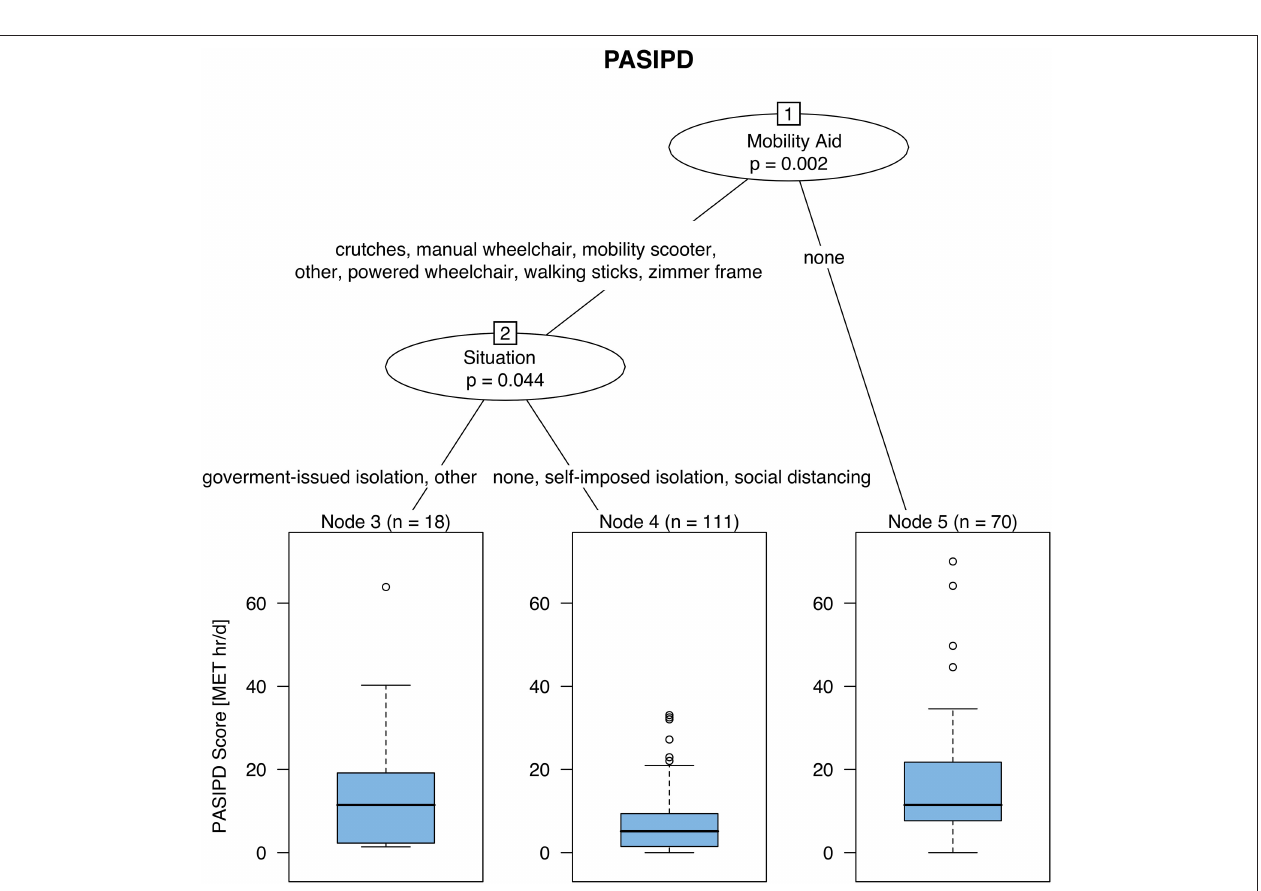
FIGURE 3 | Unbiased recursive partitioning with conditional inference tree (URP-CTREE) for total physical activity in 199 participants with neurologically-related mobility disabilities. Participants requiring no walking aid reported the highest PASIDP score, while patients relying on any kind of mobility aid AND self-isolating/social distancing were found to have the lowest PASIDP score. MET, metabolic equivalents; PASIPD, physical activity scale for individuals with physical